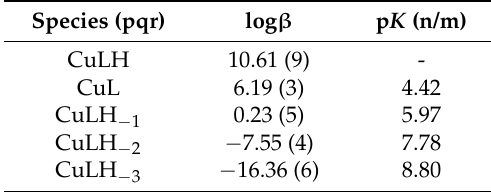
Table 1. Stability constants log β (pqr) and p K values of the complex species formed by Cu 2+